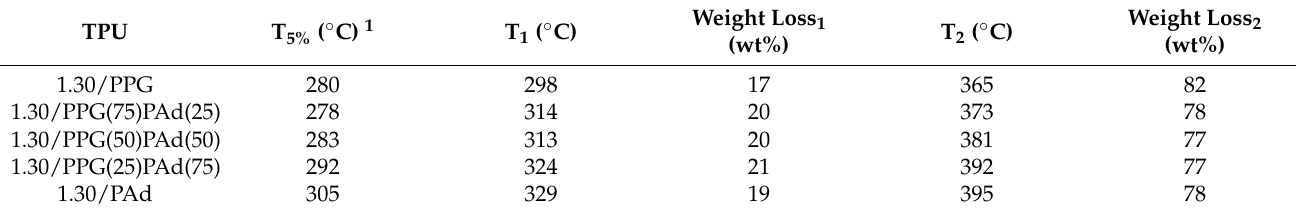
Figure 7. TGA curves of the TPUs synthesized with PPG, PAd, and PPG+PAd blends. Table 5. Temperatures and weight losses of the thermal decompositions of the TPUs. TGA experiments.